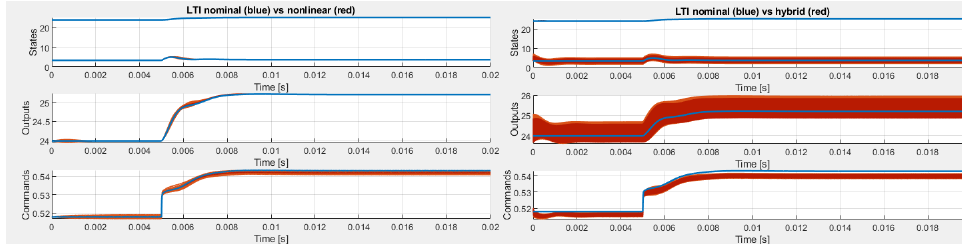
Figure 15. Boost averaged state-space and hybrid model Monte Carlo closed loop simulations with a closed loop bandwidth ω B > 650 [rad/s], equivalent to a rise time less than ≈ 1.53 [ms], negligible steady-state error and no